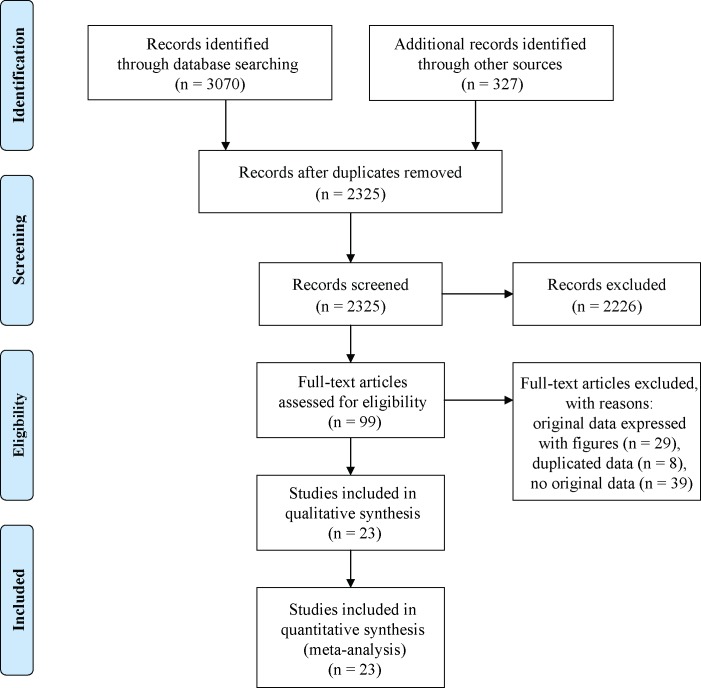
The flow chart of the articles search and inclusion process.